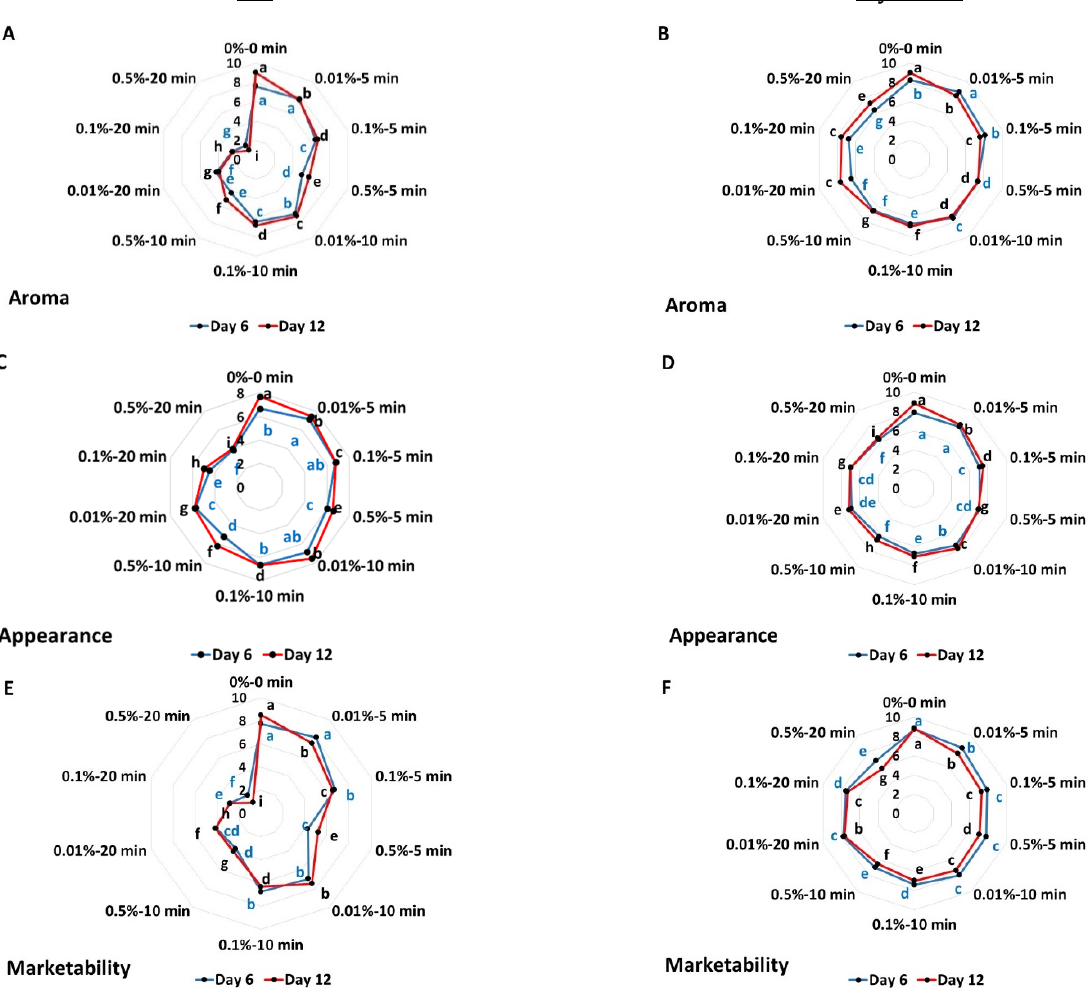
Figure 3. Screening of O. dubium EO ( A , C , E ) and hydrosol ( B , D , F ) application effects on sensory attributes (aroma, appearance and marketability) of tomato fruit stored at 11 °C for 12 days. Different Latin letters indicate significant differences at p < 0.05.